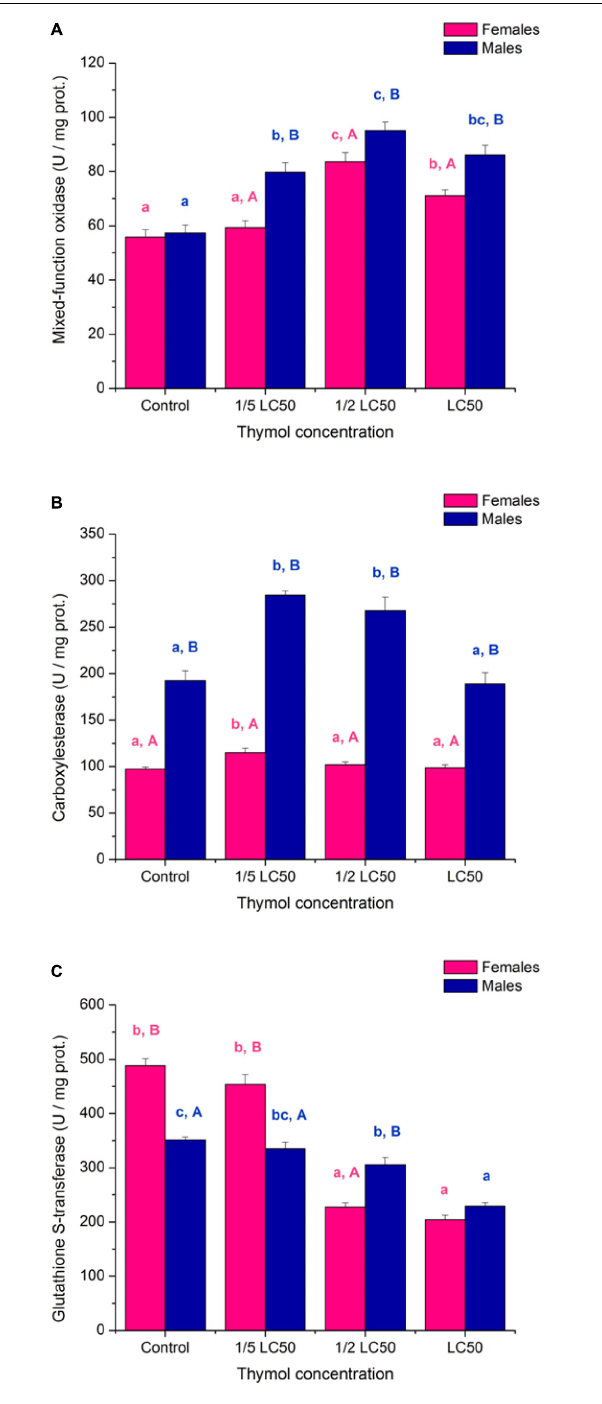
FIGURE 6 | Activity of mixed-function oxidases (A) , carboxylesterase (B) and glutathione S-transferase (C) in females and males of Acanthoscelides obtectus exposed to different thymol concentrations (means ± SE for 5 replicates). Different lowercase letters (a, b, c) mark significant differences among concentrations within each sex (Duncan’s post-hoc test, p < 0.05), whereas different uppercase letters (A, B) show significant differences between females and males within each thymol concentration (LSM contrasts, p <